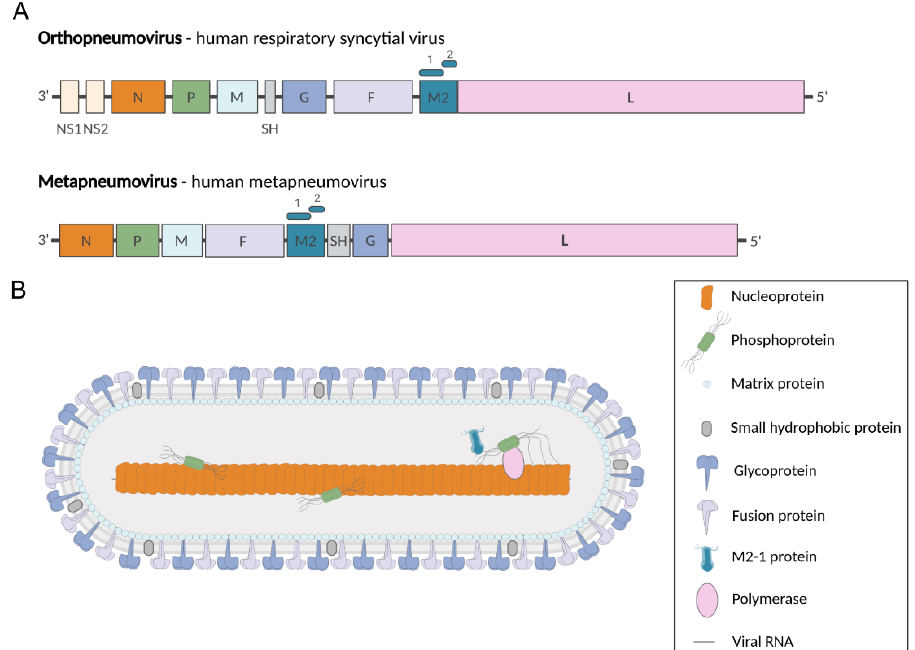
Figure 1. Pneumoviridae genomes and virion. ( A ) Genome organization of representative members of the Pneumoviridae family. Genomic RNAs are presented in sense (coding) orientation (3 ′‐ to ‐ 5 ′ ), with each box representing a gene encoding a separate mRNA drawn approximately to scale. The M2 gene encodes M1 ‐ 2 and M2 ‐ 2 proteins (represented by rectangles above M2 gene). ( B ) Representation of pneumovirus viral particle showing the structural proteins. Created with BioRender.com.